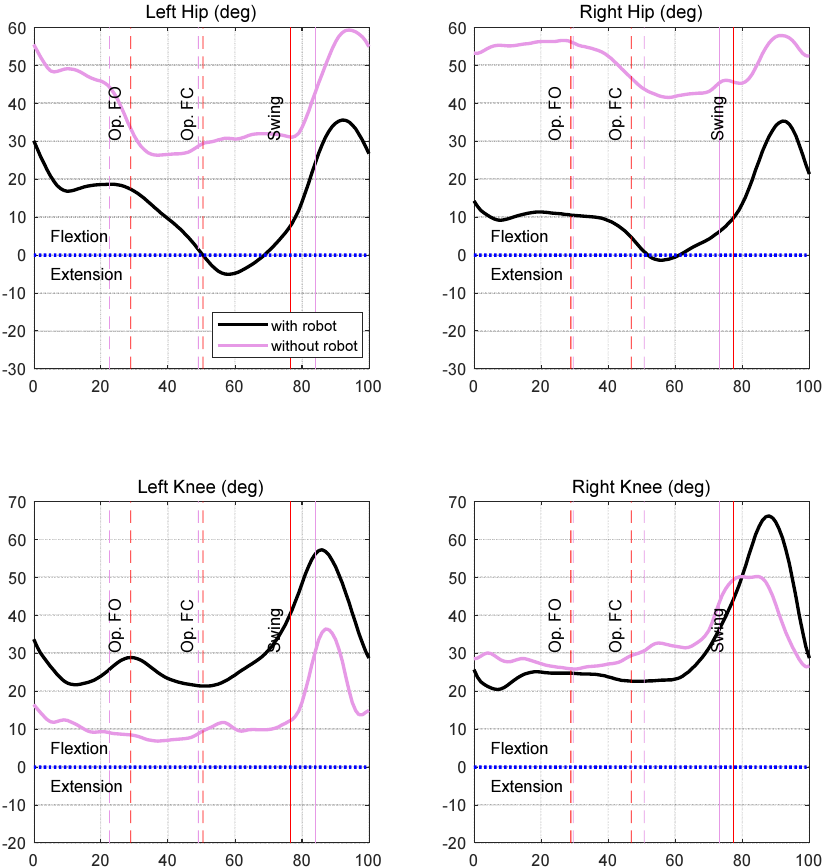
Figure 17. Kinematic results of gait analysis of walking using bilateral crutches. The solid pink line represents data without robotic assistance, and the solid black line represents data with assistance. The first vertical dashed lines represent the single limb support phase (opposite foot-off), second vertical dashed lines represent the second double limb support phase (opposite foot contact), and the solid vertical lines represent the swing